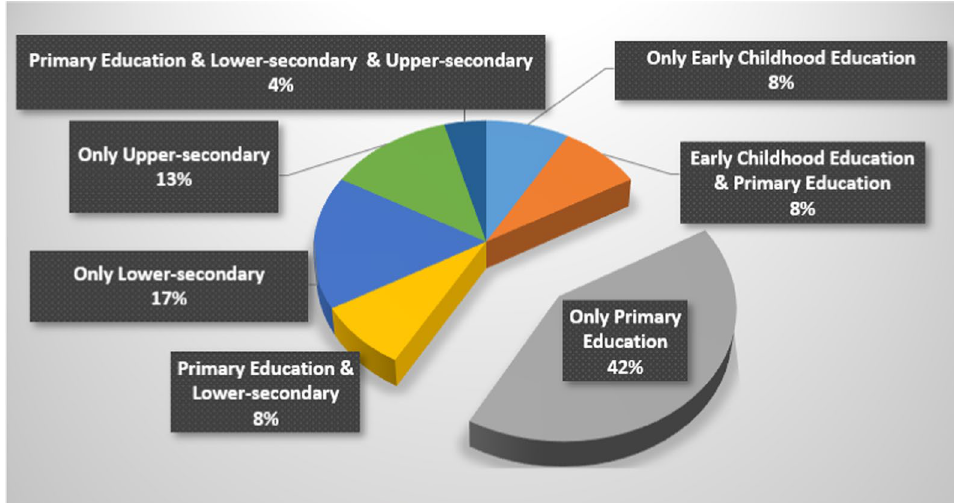
Fig. 3 Literature count of each education